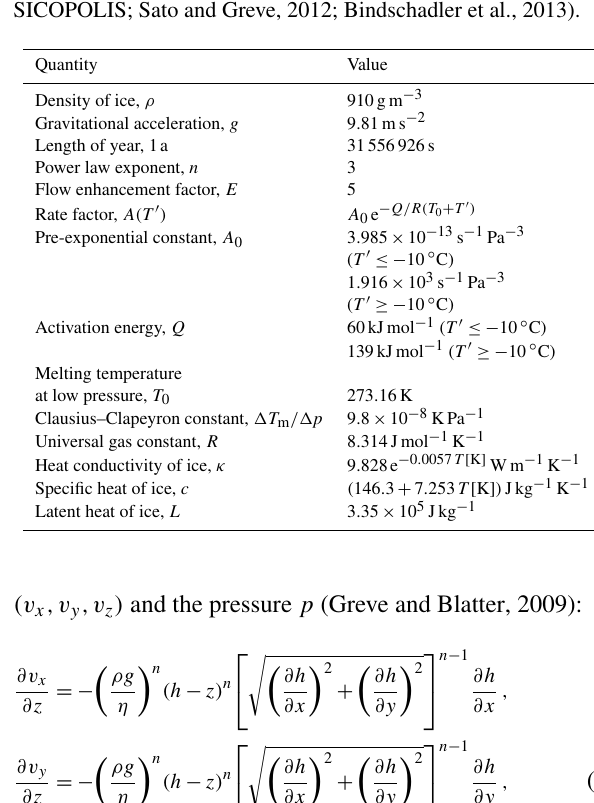
Table 1. Standard physical parameters used for the simulations with both the FS and SIA dynamics (following SeaRISE Antarctica with SICOPOLIS; Sato and Greve, 2012; Bindschadler et al.,